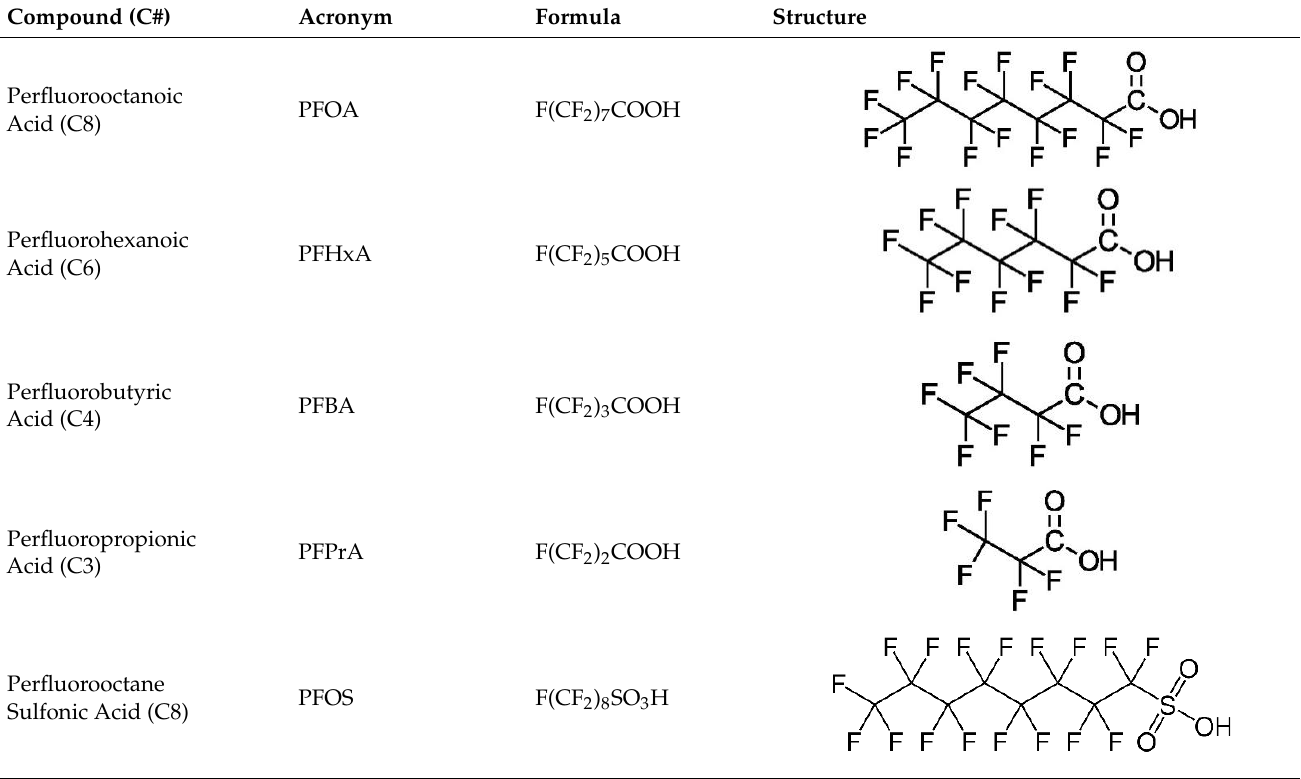
Table 1. Compound name, acronym, formula, and structure of PFAS used in laboratory and pilot-scale experiments.